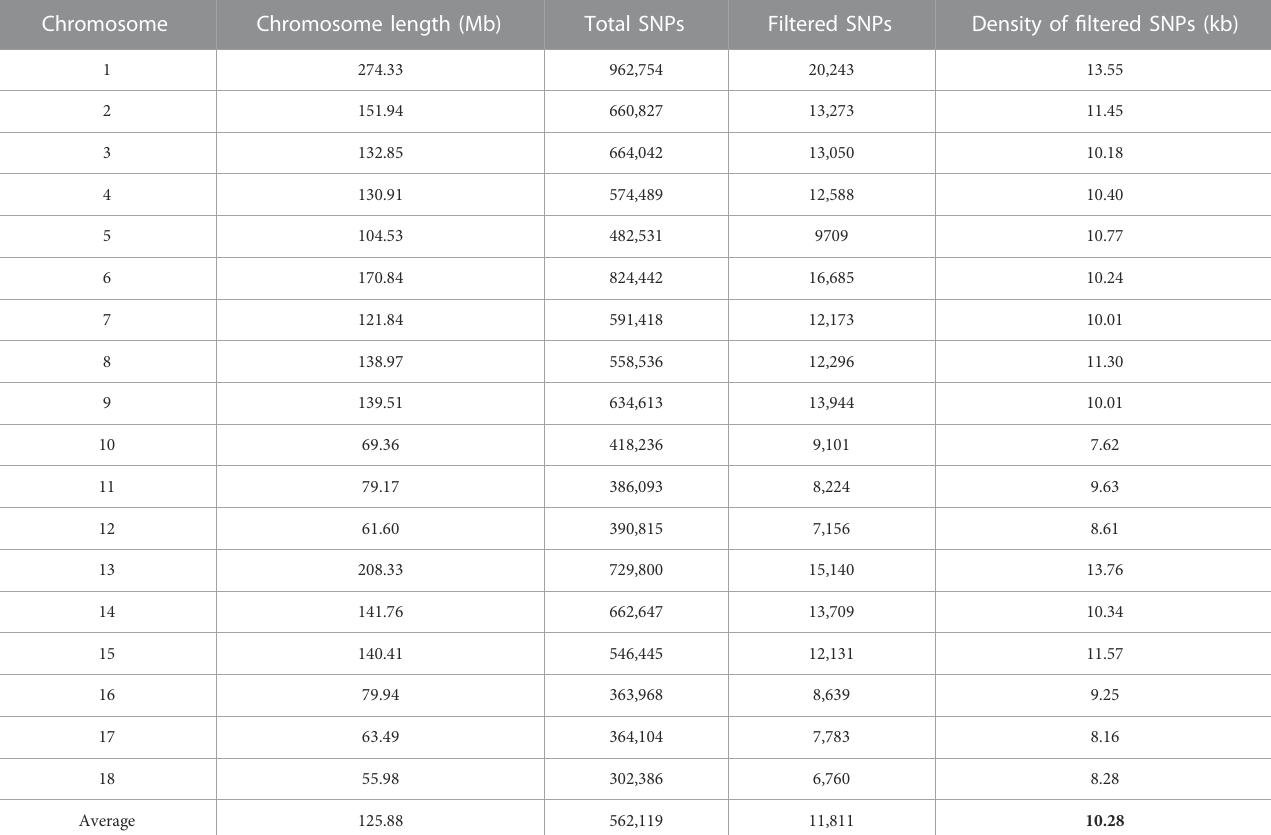
TABLE 4 SNPs distribution on each Sus Scrofa